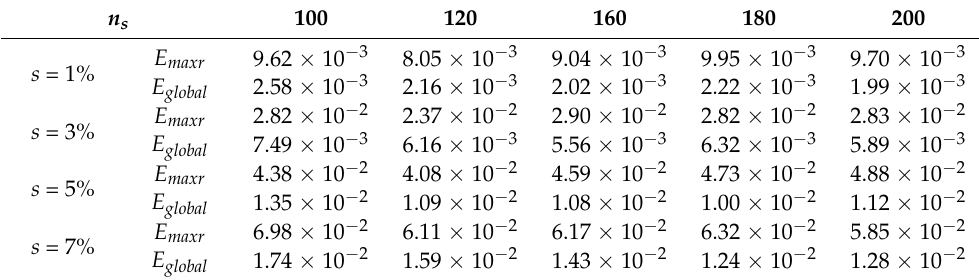
Table 6. The numerical errors with different number of local nodes.